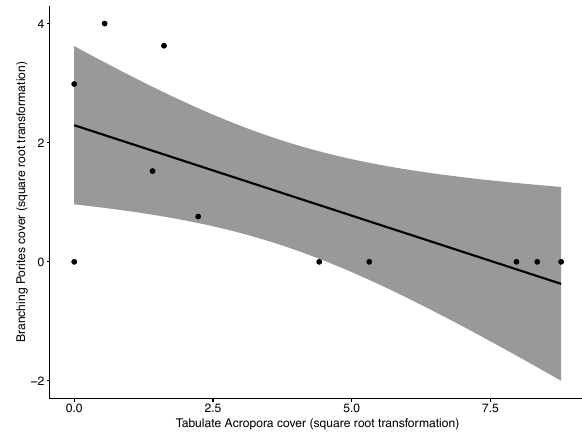
Figure 3. Plot representing the negative relationship between the percentage of live tabulate Acropora coral cover and the percentage of live branching Porites coral cover (R 2 = 41.9%, p < 0.05) identified by